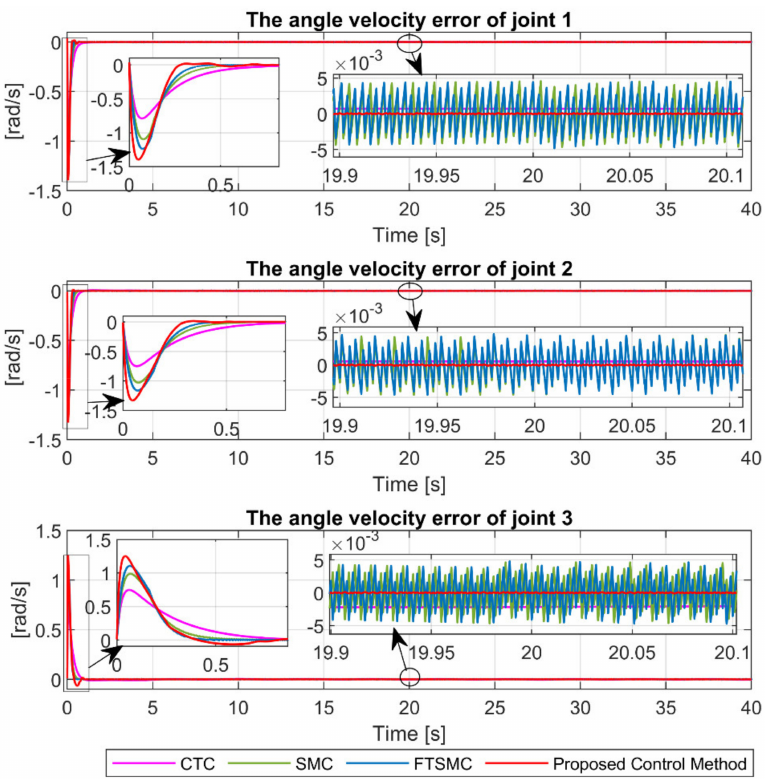
Figure 6. The tracking velocity errors of joint 1, joint 2, and joint